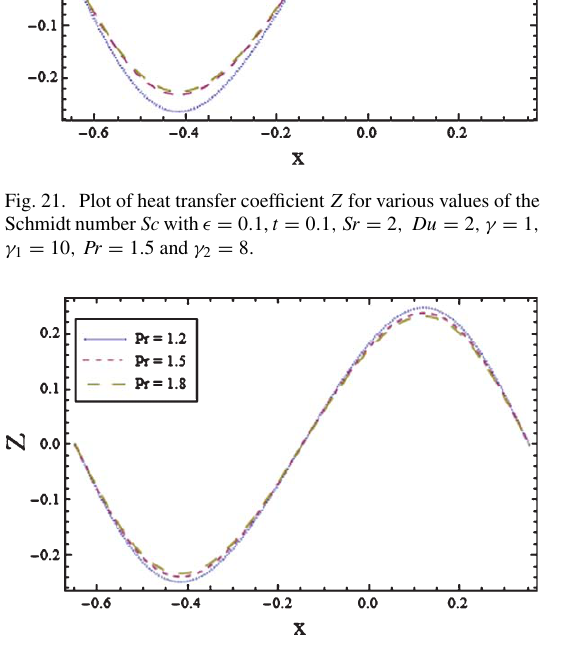
Fig. 22. Plot of heat transfer coefficient Z for various values of the Prandtl number Pr with (cid:15) = 0 . 1, t = 0 . 1 , Sr = 2 , Du = 2 , γ = 1 , γ = 10 , Sc = 2 and γ = 8 1 2